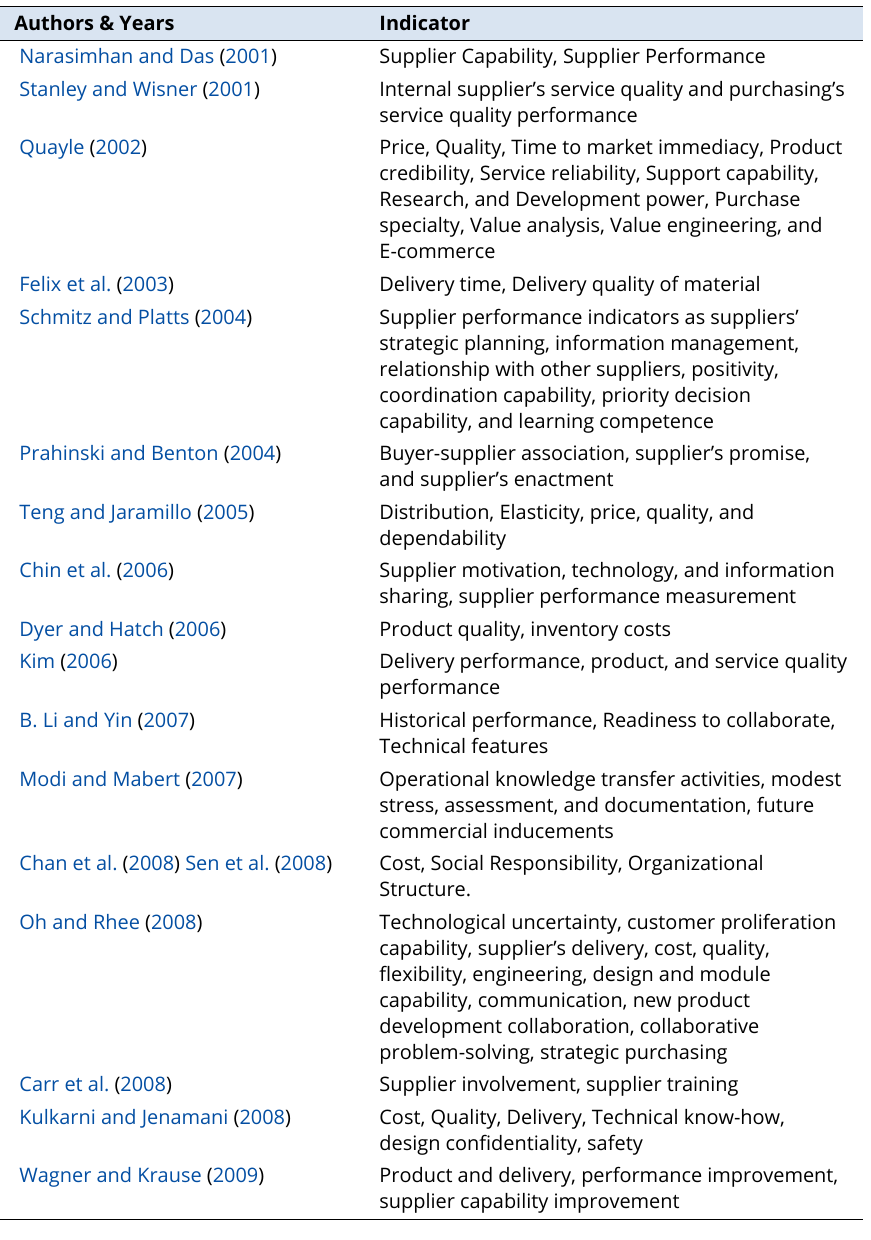
Table A. 1. KPIs of Supplier Evaluation used by different